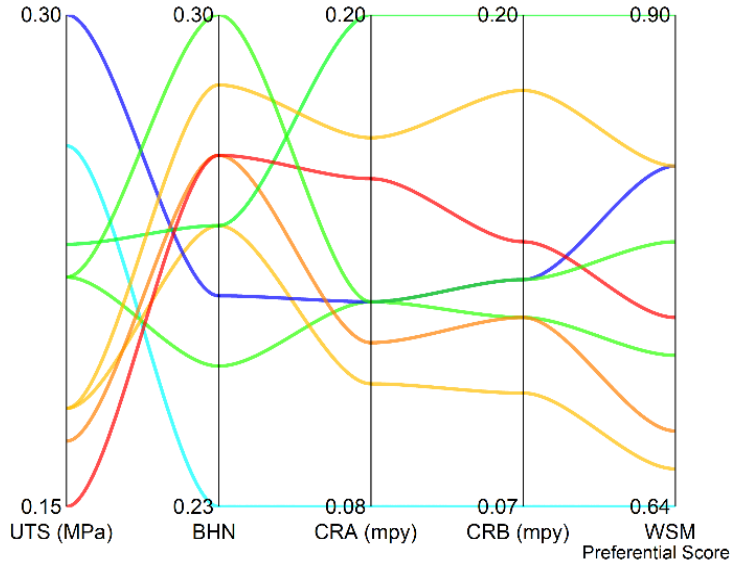
Figure 3. Parallel plot denoting the weighted vectors and weighted sum model (WSM) preferential score.